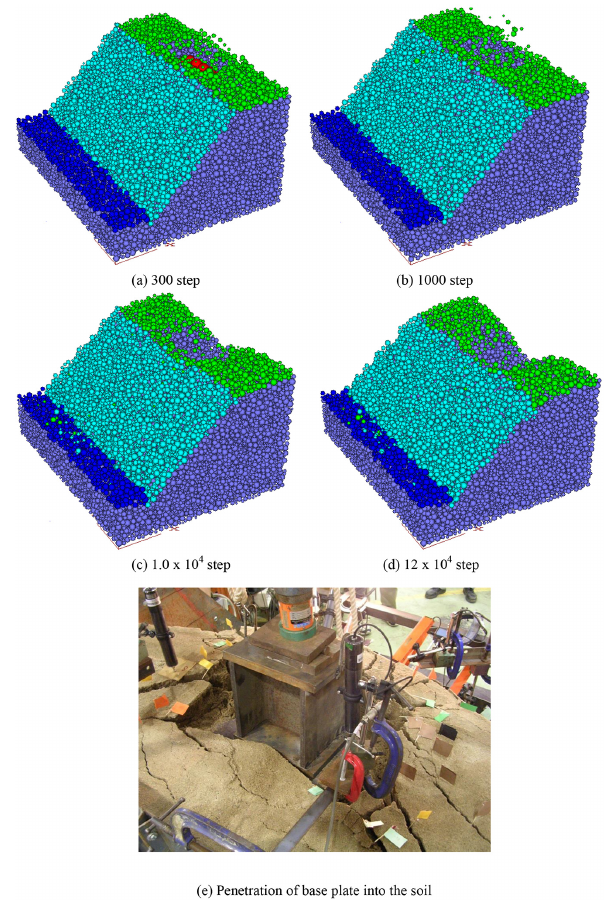
Figure 9. Failure process of the numerical slope model under the loading